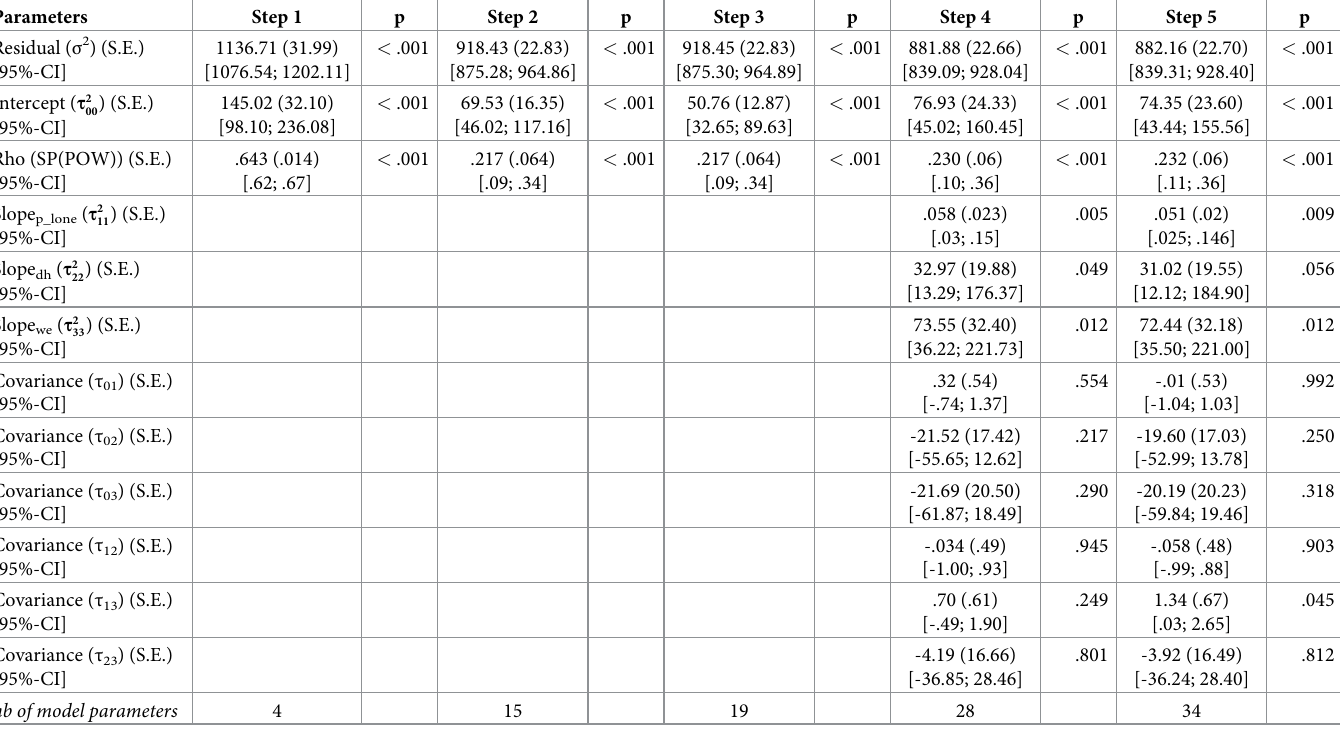
Table notes. (S.E.) standard errors given in parentheses; [95%-CI] 95%-confidence interval of coefficient